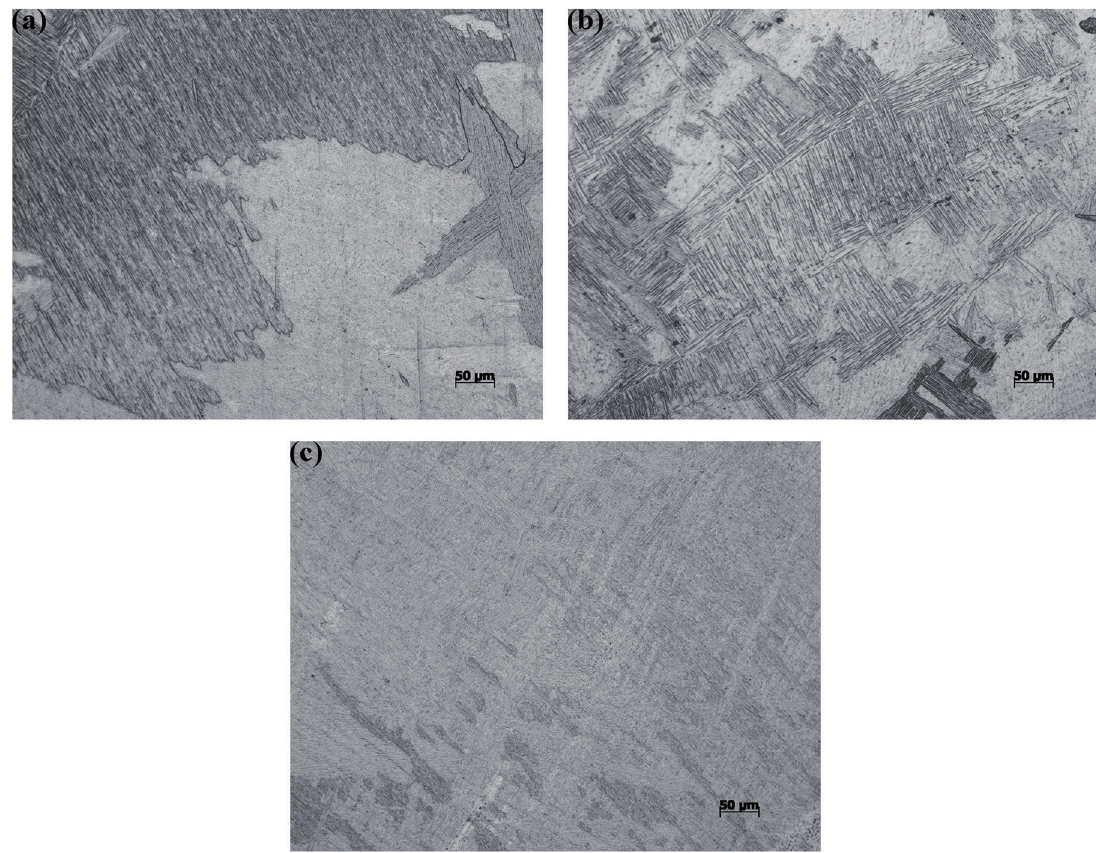
Figure 2: Microstructures of Ti-6Al-4V-0.1Ru at the temperatures of (a) 1188 K; (b) 1198 K and (c) 1208 K.